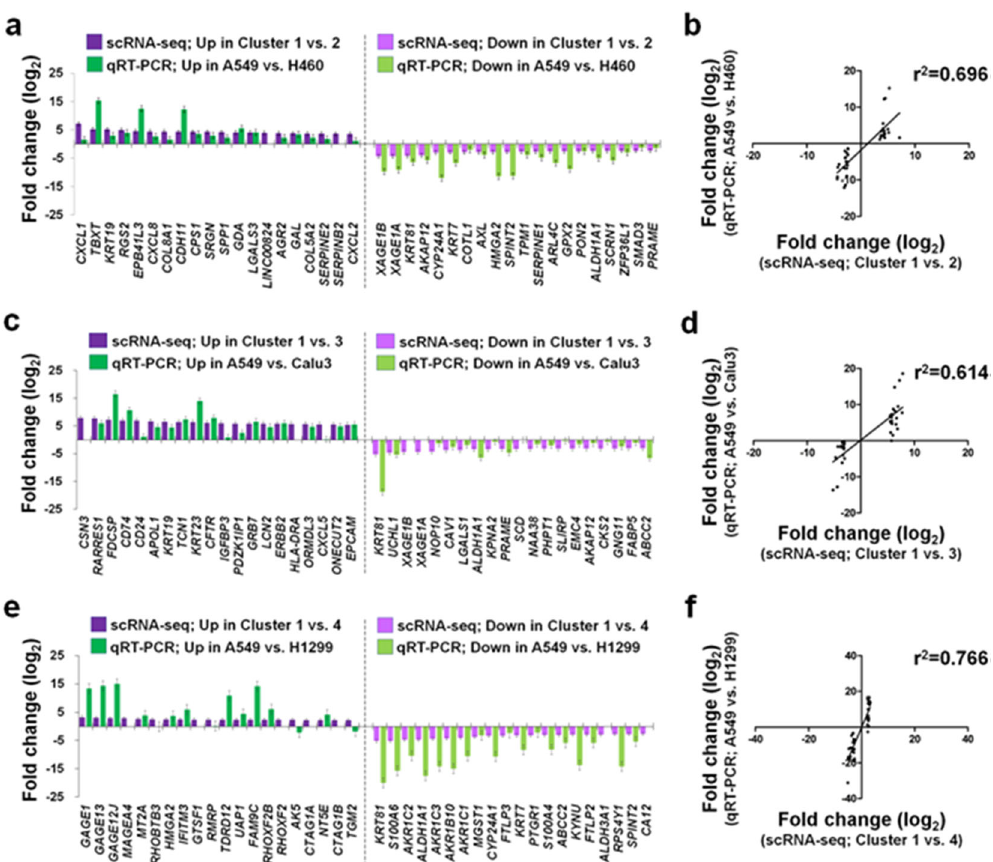
Fig. 4 Validation of scRNA-seq DEGs by qRT-PCR analysis. a , c , e Direct comparison of fold change for selected scRNA-seq DEGs ( n = 120) detected from three cluster comparisons, Cluster 1 vs. Cluster 2 in ( a ), Cluster 1 vs. Cluster 3 in ( c ), and Cluster 1 vs. Cluster 4 in ( e ), compared with genes identi fi ed in A549 vs. H460 in ( a ), A549 vs. Calu3 in ( c ), and A549 vs. H1299 in ( e ), using qRT-PCR. Prioritized DEGs ( n = 120) are comprised of the fi rst 20 up- and the fi rst 20 down-regulated genes (40 DEGs) per cluster comparison. X and y axes indicate gene names and fold-change values (log 2 ), respectively. Fold-change values expressed as mean ± SEM; three separate experiments conducted in duplicate. b , d , f Linear regression analysis was conducted for fold-change values of prioritized 120 selected DEGs between Fluidigm 3 ′ -end scRNA-seq ( x axes) and qRT-PCR ( y axes) analyses corresponding to the direct fold-change comparisons in ( a ), ( c ), and ( e ), respectively. Coef fi cient of determination ( r 2 ) values are presented at P value <